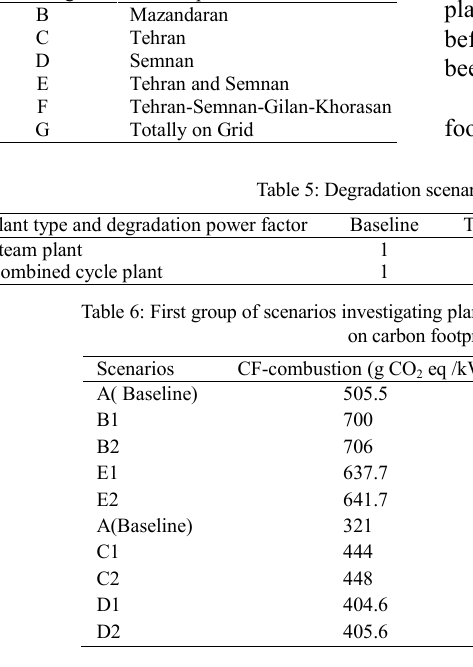
Table 4: Consumption location (Transmission and distribution losses) scenarios description No. Scenario tag No. Consumption location 1